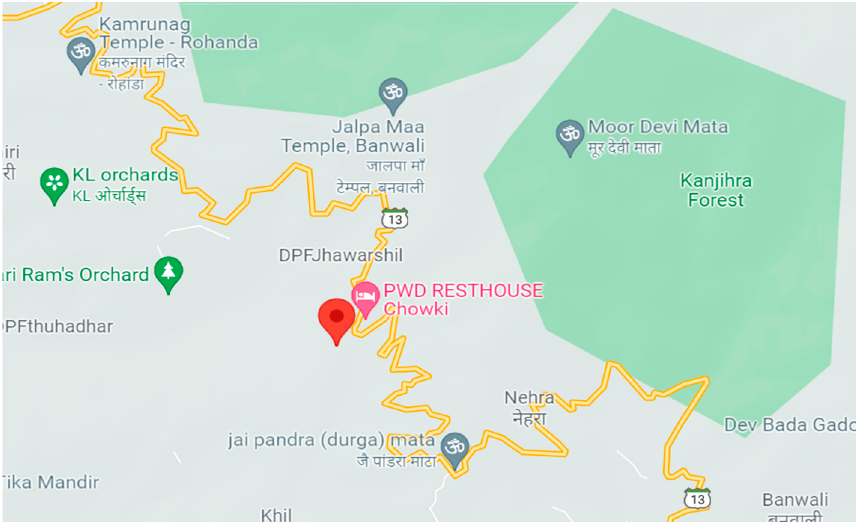
Figure 1. Monitoring site location displayed using Google Maps.